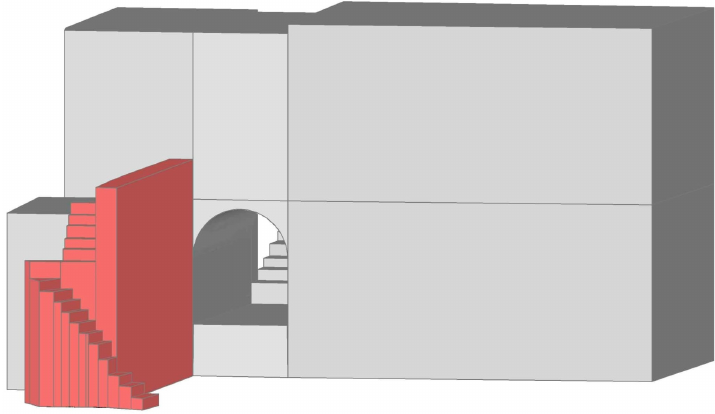
Figure 14. The integrated legal-physical model; where the cross-model constraint is violated is shown in red.